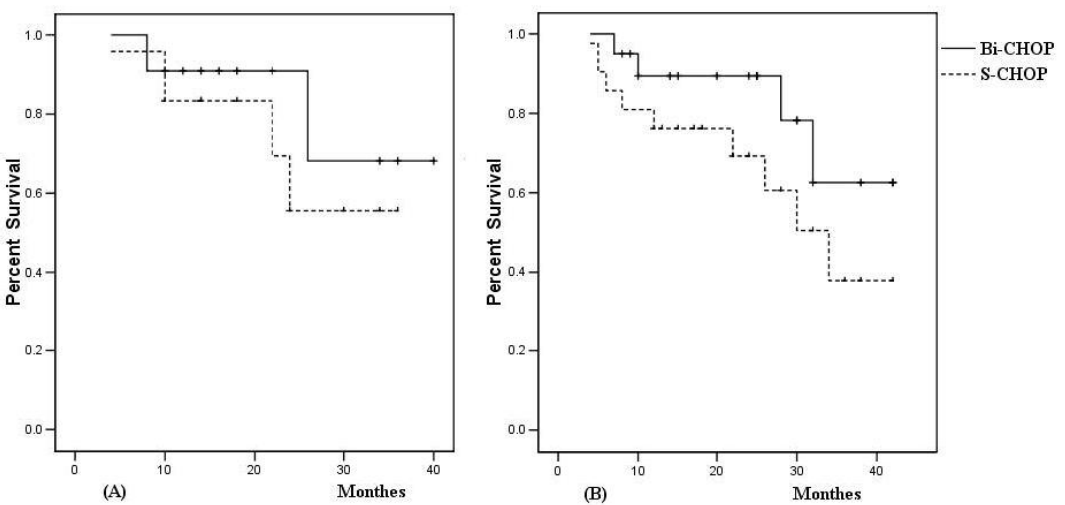
Fig. 2 Overall survival for 64 DLBCL based on cell